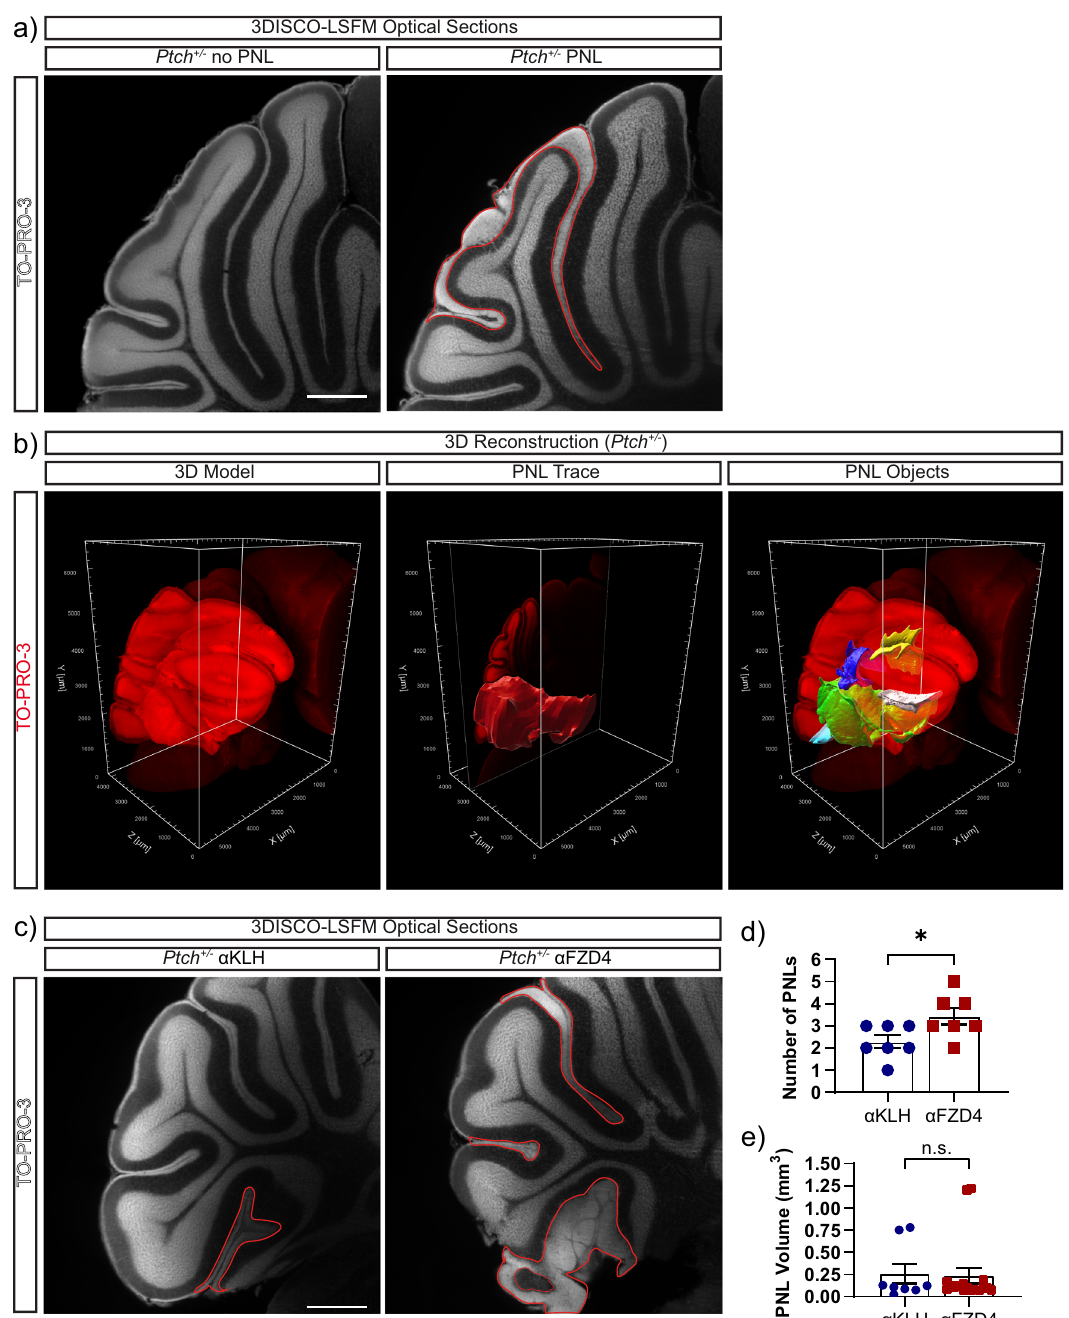
Fig. 2 3DISCO-LSFM analysis of Norrin/Fzd4-dependent PNL formation in the Ptch + / − cerebellum. a TO-PRO-3 (white) stained optical sections at the primary fi ssure from two different P14 Ptch + / − mice. In comparison to a sample without preneoplasia, a PNL (outlined in red) displays as a distinct hyperplastic region in the EGL. b PNLs are identi fi ed and quanti fi ed from analysis of the 3D reconstruction of the cerebellum. TO-PRO-3 positive PNL signal is isolated from the rest of the cerebellum by manually segmenting it in 2D and combining individual traces across the sagittal axis to create a surface object representing the boundary of the PNL. A new surface object is created by masking the TO-PRO-3 channel, within the fi rst PNL surface object, whose volume represents the true volume of the PNL. This procedure is performed for each PNL in the cerebellum (white, yellow, blue, cyan). c TO-PRO-3 stained (white) single optical slices showing PNLs (outlined in red) in P14 Ptch + / − mouse cerebella after treatment with anti-Fzd4 ( α Fzd4) and anti-KLH control ( α KLH) antibodies. Quanti fi cation of PNL number ( d ) and volume ( e ) in Ptch + / − mice shows that the number of PNLs are increased in mice treated with α Fzd4 ( n = 7 mice) compared with control α KLH ( n = 7 mice) antibodies. * p < 0.05, p = 0.0306 (unpaired two-tailed t -test). PNL number is reported for half of the cerebellum. e There was no difference in the average PNL volume in mice treated with α Fzd4 ( n = 24, PNLs) and α KLH ( n = 11, PNLs) antibodies. n.s. p > 0.05, p = 0.4508 (Mann − Whitney test). Error bars represent s.e.m. Scale bars: 1000 µ